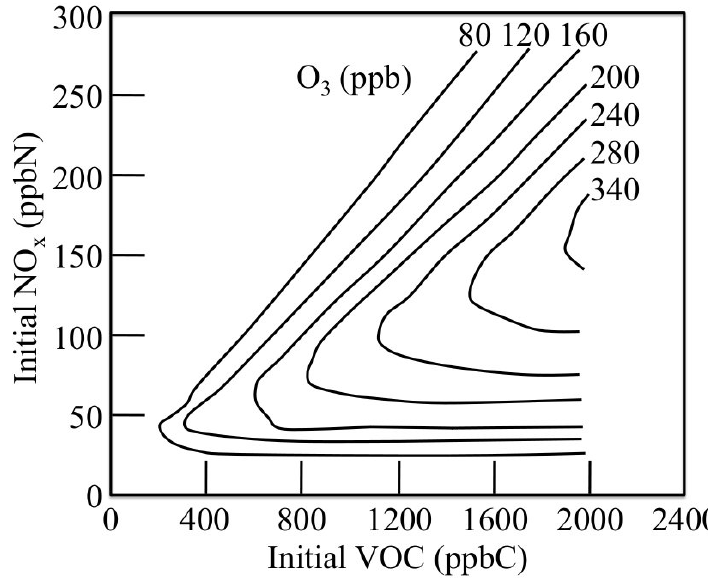
Figure 1. Typical ozone isopleth generated with the RADM mechanism